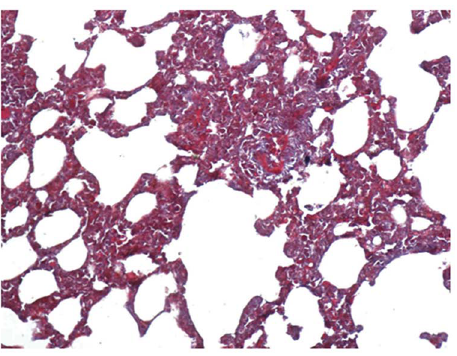
Figure 6. Masson stain of bosentan group ( 6 200). The damage is improved relative to the PQ group. Alveolus interstitium was thinner